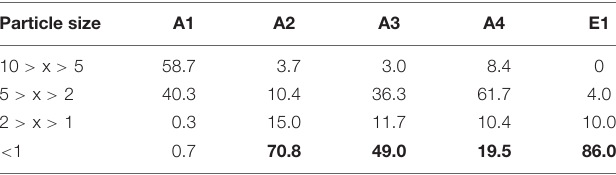
TABLE 2 | Particle size distribution of chars from thermocatalytic reforming of digestate (A1), poultry litter (A2), and wood pellet (A3) and from pyrogasification of wood pellet (A4) and brushwood (E1).